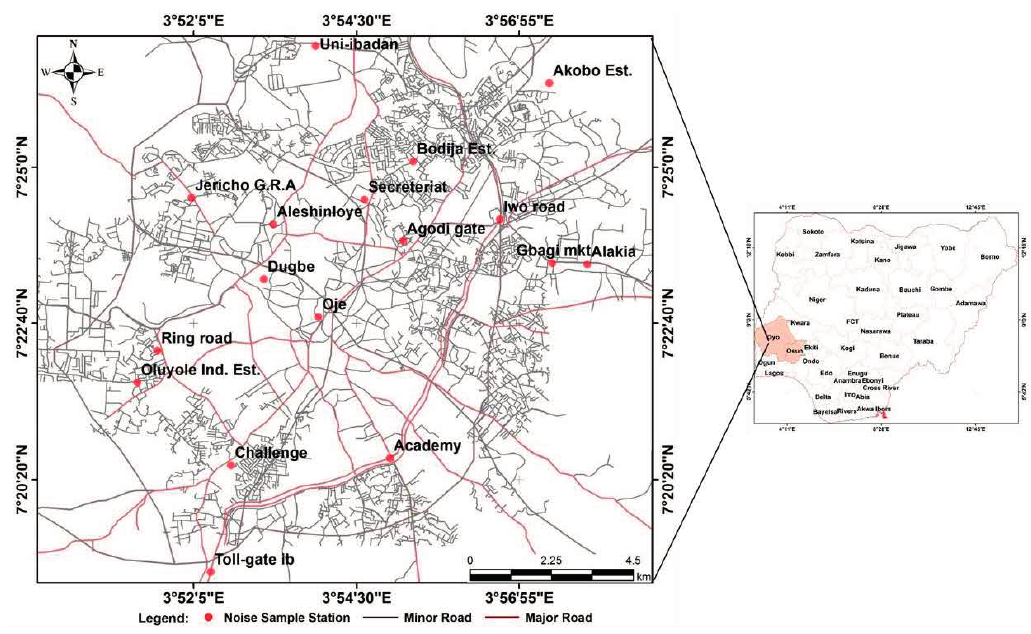
Figure 1. Map of Ibadan